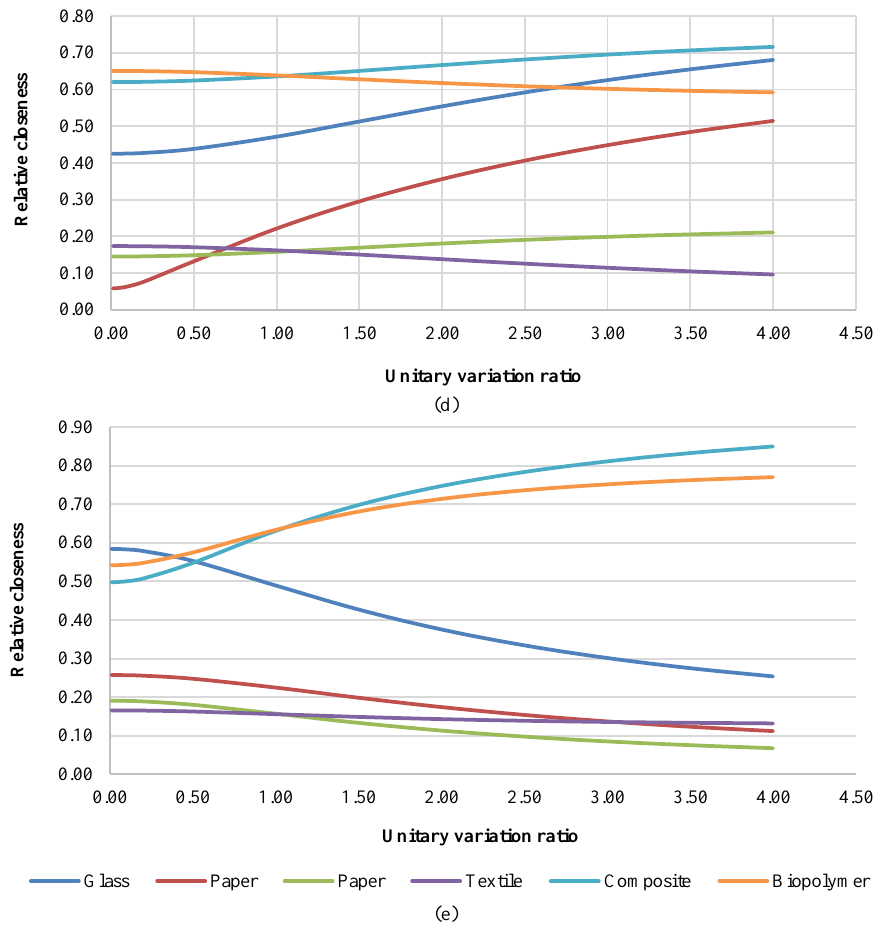
Fig. 3. Sensitivity analysis of weight distracted five parameters: (a) w 1 ; (b) w 2 ; (c) w 3 ; (d) w 4 ; (e) w 5